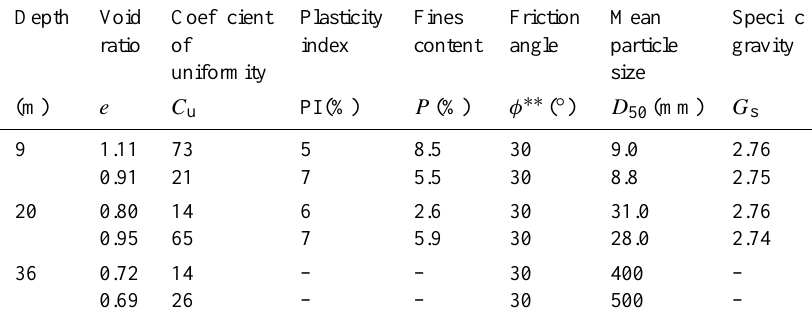
Table 3. Material properties of Xiaogangjian Landslide Dam. Depth Void Coefficient Plasticity Fines Friction Mean Specific ratio of index content angle particle gravity uniformity size (m) e C u PI(%) P